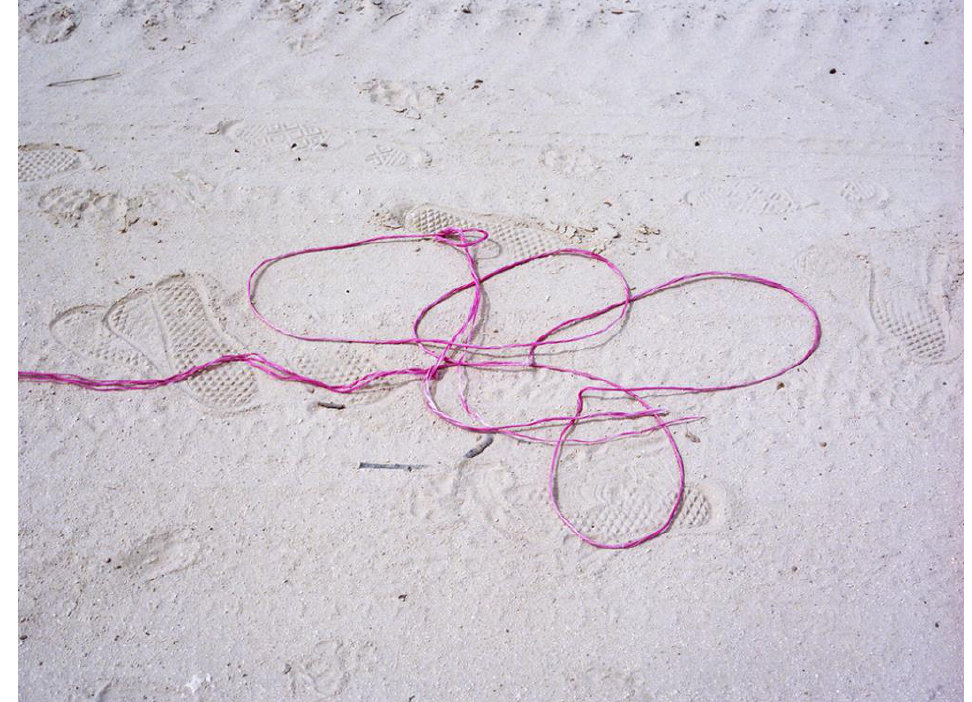
Figure 3 Jezabeth Roca Gonzalez, Gringolandia , 2017-2018,